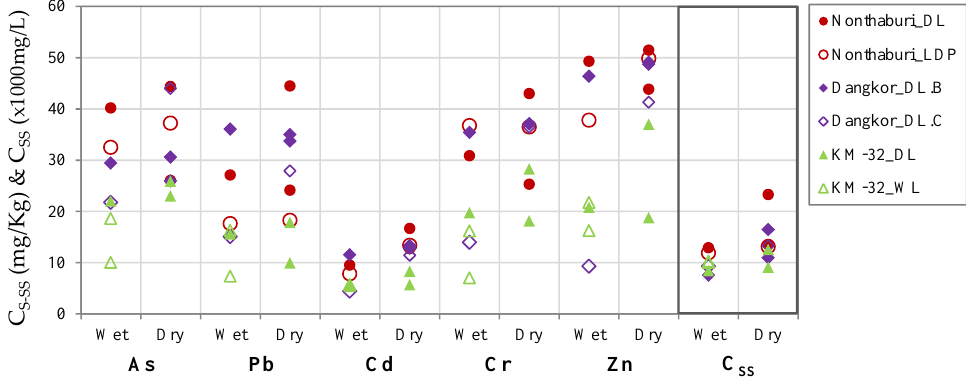
Figure 10. Heavy metal content of suspended solids (C S - SS ) of leachate samples.